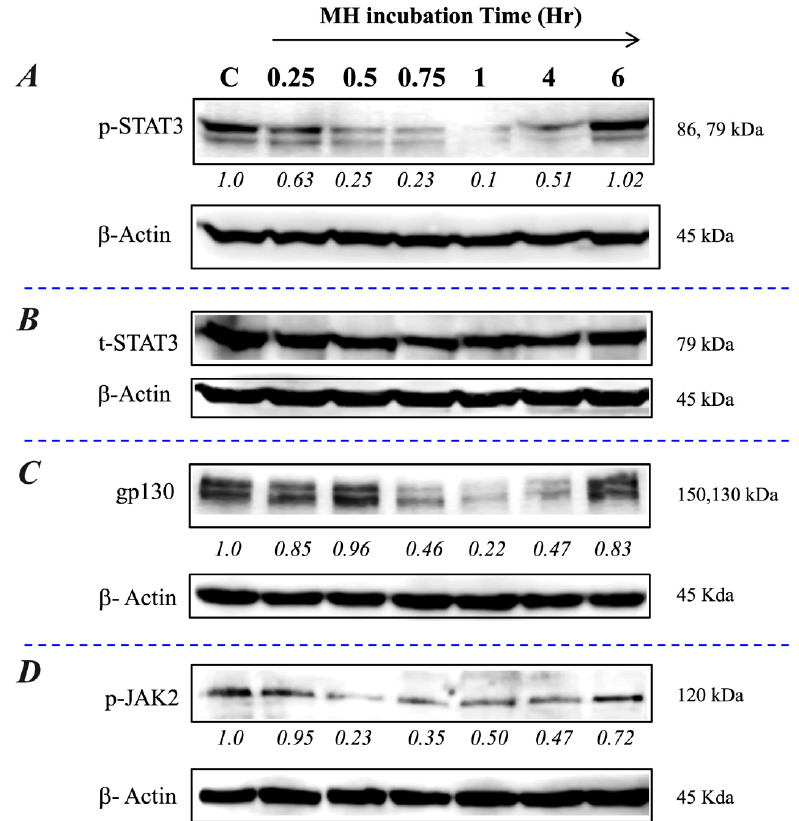
Figure 2. MH inhibits the IL-6 receptor pathway in lung cancer cells. A549 cells were exposed to 1% MH or SC solution and analyzed as described in the Figure 1 legend for MDA-MB-231 cells. Relative levels of p-STAT3 ( A ), total STAT3 ( B ), gp130 ( C ), and p-JAK2 ( D ) were examined by Western blots. The numbers below each blot indicate changes in the band intensity compared to the control, as determined by densitometric analysis. The data are representative of two independent